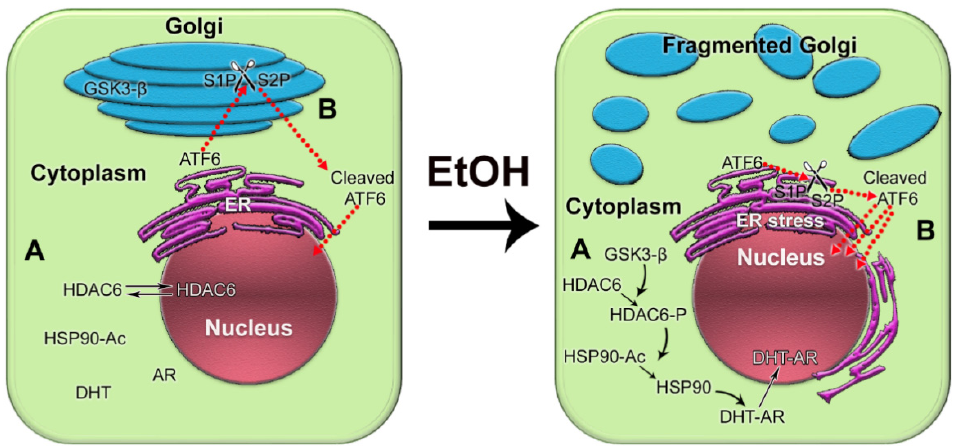
Figure 4. The impact of alcohol-induced Golgi disorganization on prostate carcinogenesis. ( A ) In normal prostate cells or low aggressive PCa cells, HDAC6 is distributed in both the nucleus and the cytoplasm. Typically, the phosphorylation of HDAC6 is moderate because the enzyme that phosphorylates HDAC6, GSK3 β , is sequestered primarily within the Golgi. The acetylated HSP90 has a limited binding capacity to AR. EtOH treatment results in Golgi fragmentation and translocation of GSK3 β to the cytoplasm, which results in increased phosphorylation of HDAC6. HDAC6-P deacetylates HSP90, which, in turn, accelerates conformational maturation of AR, its binding to DHT, and translocation to the nucleus. ( B ) In normal prostate and low-aggressive PCa cells, ATF6 α is cleaved sequentially in the Golgi by S1P and S2P proteases. The dimeric form of trans -golgin GCC185 is the retention partner for both S1P and S2P. Cleaved ATF6 enters the nucleus and binds to ER stress- response elements, stimulating the expression of UPR genes. EtOH and its metabolites fragment Golgi membranes, which is associated with the monomerization of GCC185 and the subsequent shift of S1P and S2P to the ER. This simplifies and accelerates ATF6 cleavage, resulting in more prominent UPR signaling to maintain tumor cell growth and proliferation.